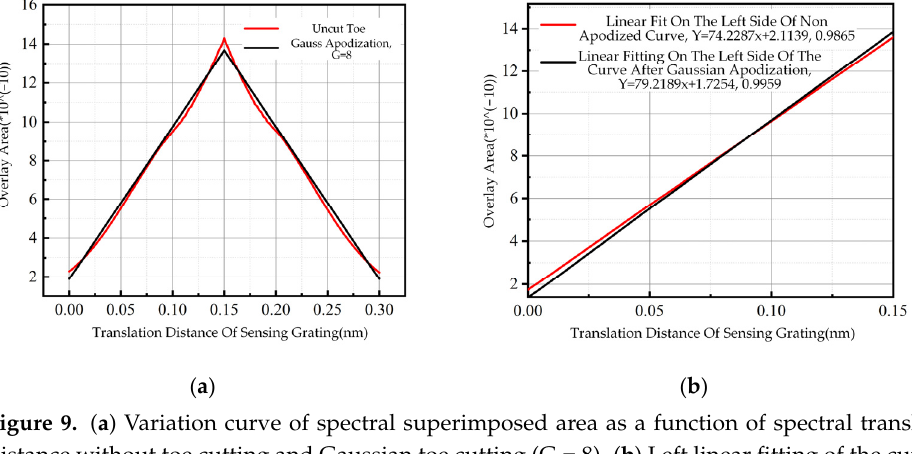
Figure 9. ( a ) Variation curve of spectral superimposed area as a function of spectral translation distance without toe cutting and Gaussian toe cutting (G = 8). ( b ) Left linear fitting of the curve of spectral superimposed area change.